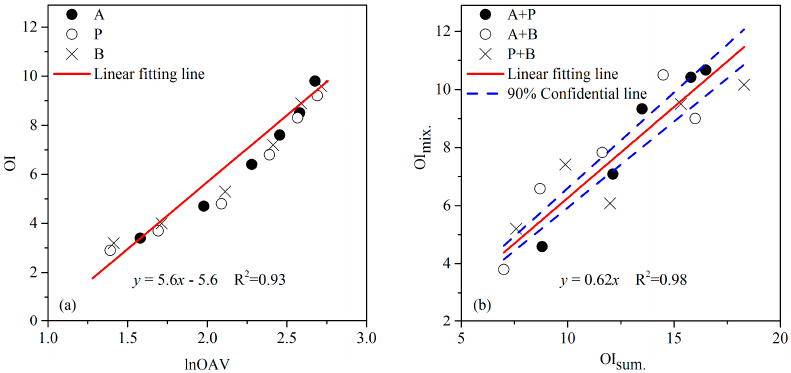
Figure 1. The ( a ) linear relation between odor intensity (OI) and logarithm of odor activity value (lnOAV) of individual aldehydes (acetaldehyde, A; propionaldehyde, P; n -butyraldehyde, B), and ( b ) the relationship between OI of a binary odor mixture (OI mix. ) and the summation of its unmixed constituents’ odor intensities (OI sum. ).